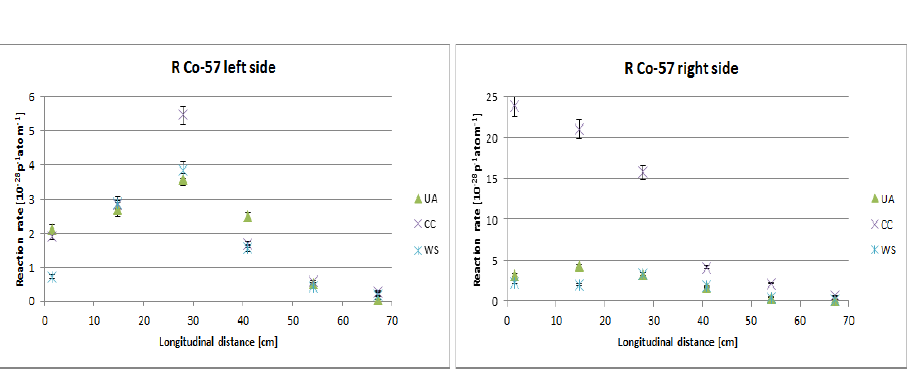
Figure 3. Experimental reaction rates of 57 Co production for all the Phasotron experiments for samples on the left and right